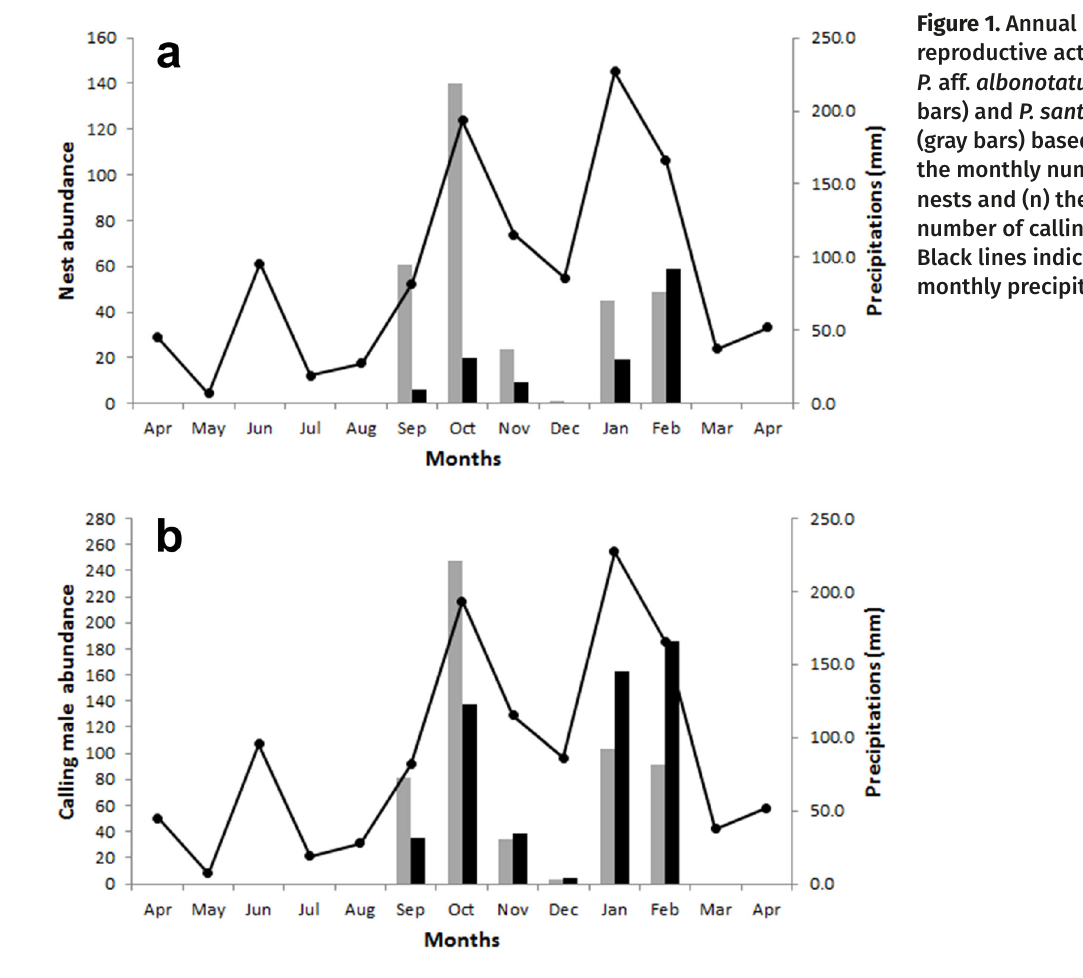
Figure 1. Annual reproductive activity of P. aff. albonotatus (black bars) and P. santafecinus (gray bars) based on (a) the monthly number of nests and (n) the monthly number of calling males. Black lines indicate the monthly